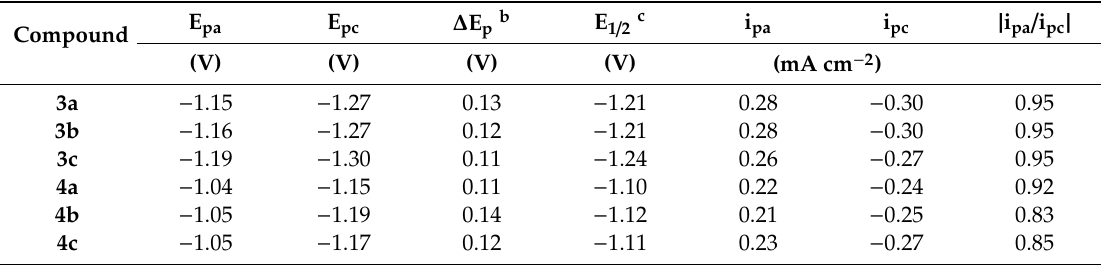
Figure 3. Schematic representation of the quinone moiety ( Q ) reduction in the naphthoquinone amino acid derivatives: (i) single step two-electron reduction reaction and (ii) two successive one-electron reduction reactions. X = H for 3a–c and X = Cl for 4a–c. Table 2. Electrochemical parameters of non-chloride and chloride naphthoquinone with tyrosine, valine and tryptophan substituents a